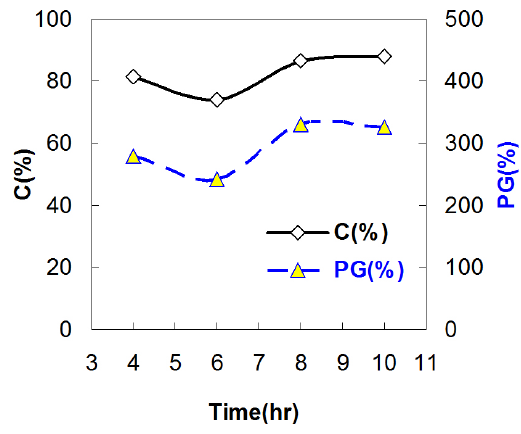
Figure 4. Effect of w(BA)/ w(MMA) on C% and PG% (Cond.: w(PoSt) / w(Monomers) = 1: 4, KPS: 1.50 wt.%, Temp: 85°C, Time: 8 hours).